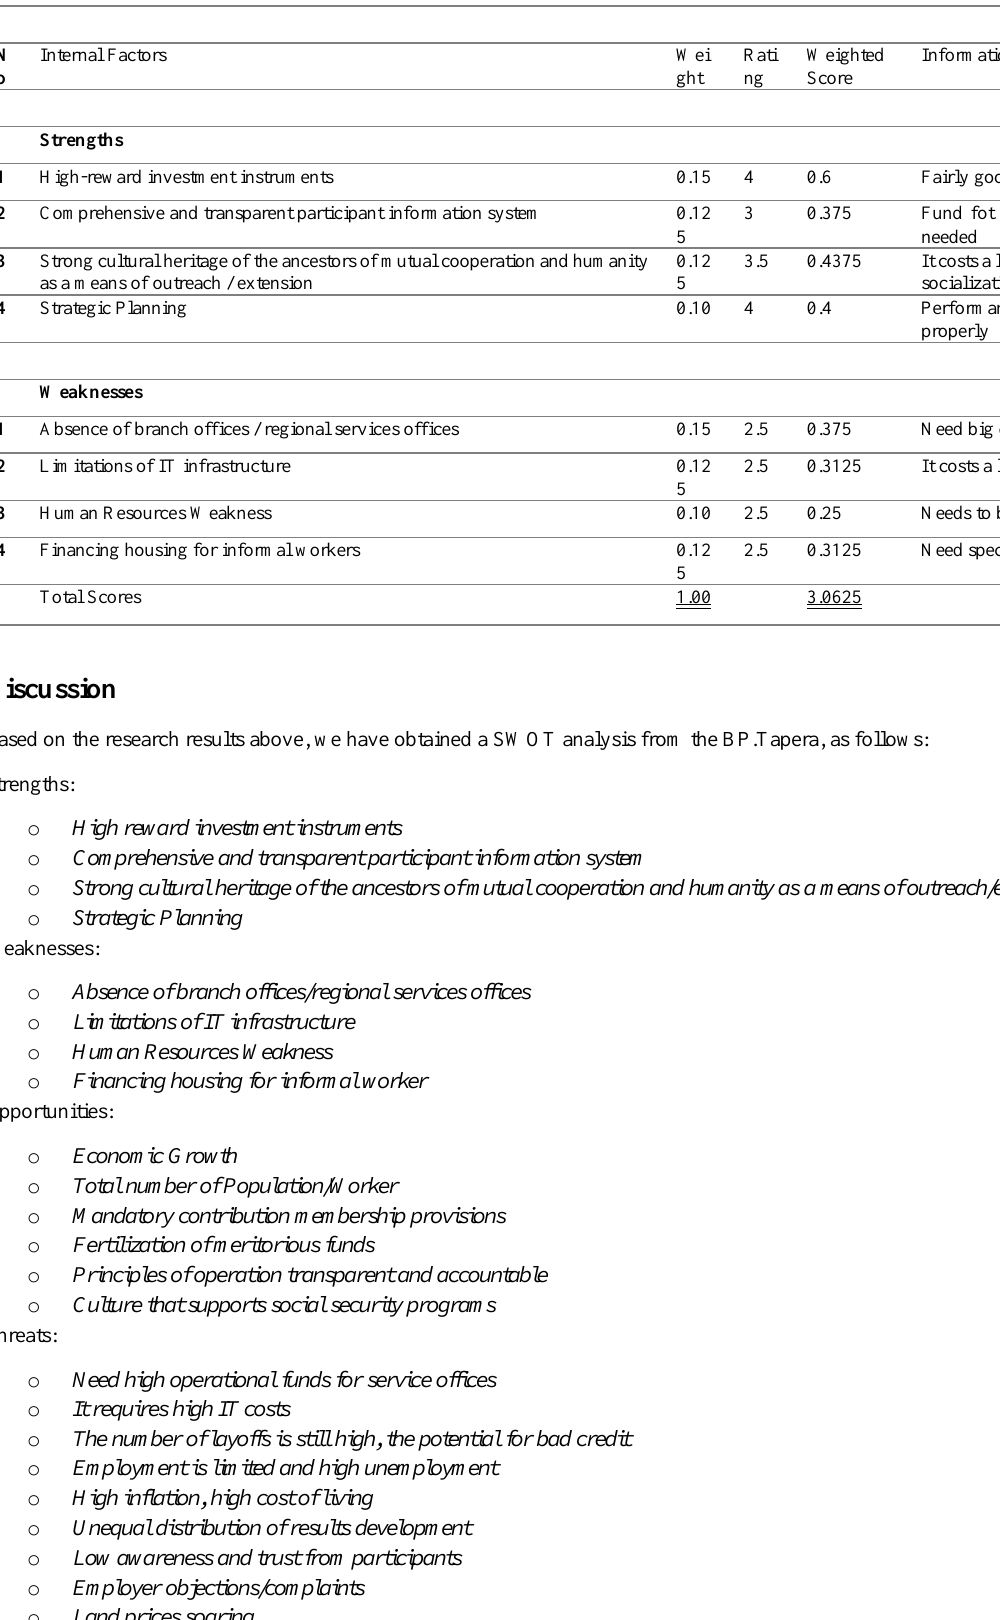
Table 3: IFAS of Program